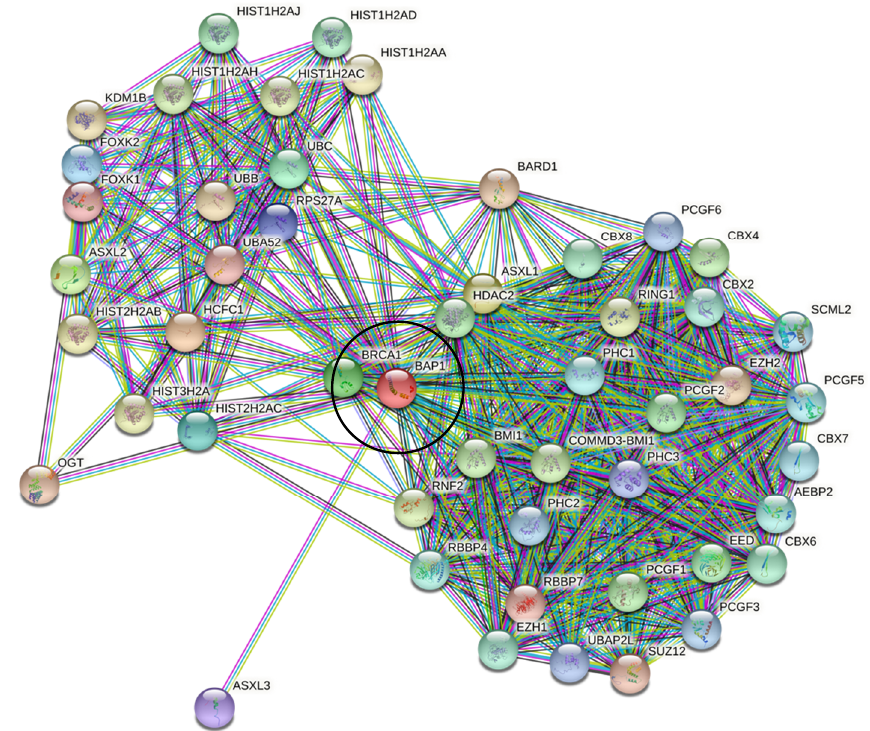
Figure 4. Search Tool for the Retrieval of Interacting Genes (STRING) output for BAP1. The graphic demonstrates that BAP1 (black circle) interacts with (lines) multiple proteins (colored circles). The ability for BAP1 to interact with 49 other proteins is likely possible through the utilization of IDPRs. The number of edges in this protein interaction network is 599, and the expected number of edges for randomly selected proteins of the same-sized network is 101 ( p -value < 1.0 × 10 −16 ).